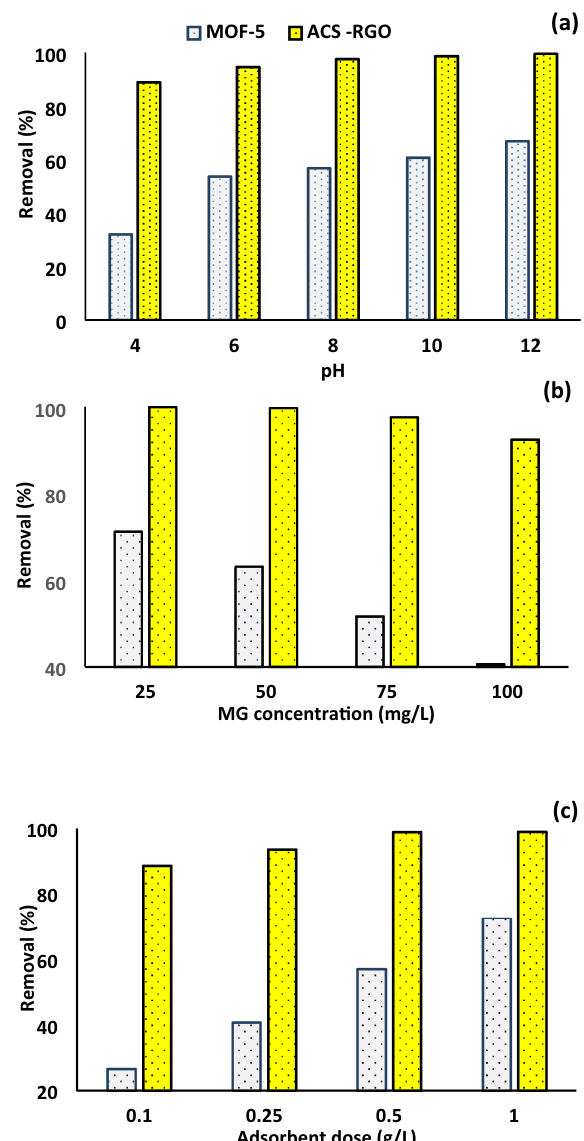
Figure 5. Parametric study of MG removal by ACS-RGO and MOF-5, ( a ) pH, ( b ) MG concentration, and ( c ) adsorbent